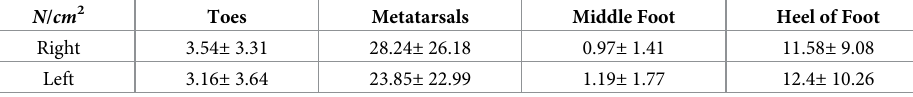
Table 1. Average foot-pad pressure ratios